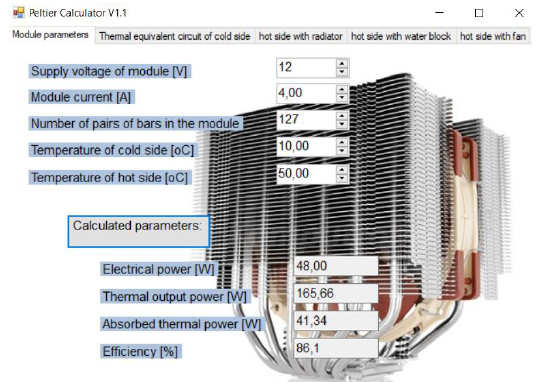
Fig. 3. Main form of the computer program .